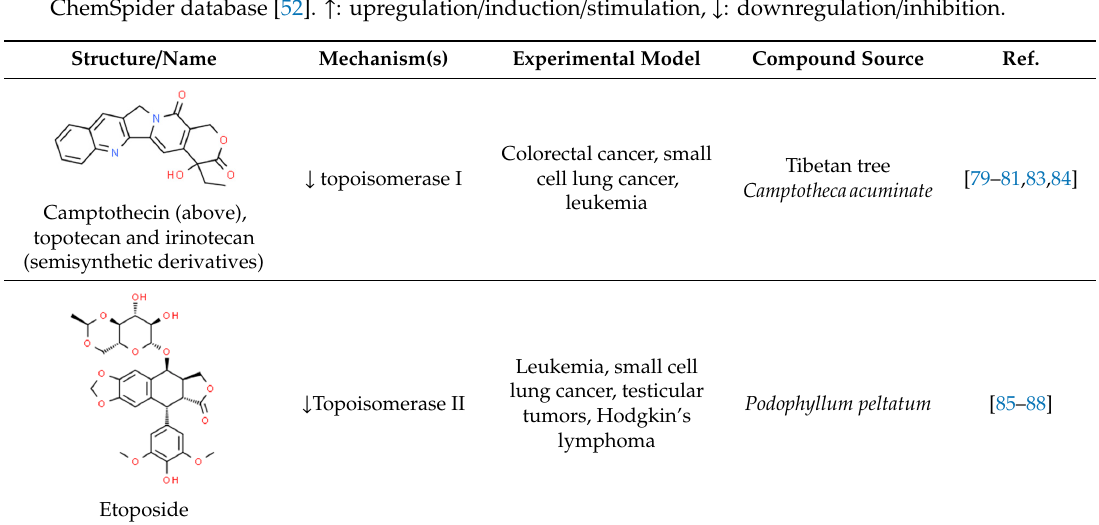
Table 2. Topoisomerases inhibitors—a brief summary. Images of the chemical structures obtained from